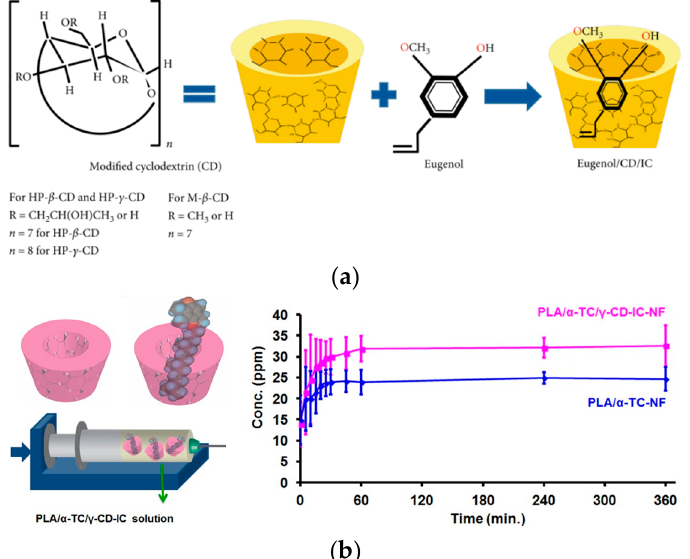
Figure 12. ( a ) Chemical structure of modified CD, eugenol, and schematic illustration of IC formation between CD and eugenol; Reprinted with permission from Ref. [178], Copyright 2020 Shahla Ataei et al. ( b ) schematic representations of γ -CD and α -TC/ γ -CD–IC, electrospinning of nanofibers from a PLA/ α -TC/ γ -CD–IC solution and cumulative release of α -TC from PLA/ α -TC–NF and PLA/ α -TC/ γ -CD–IC–NF into 95% ethanol. Reprinted with permission from Ref. [187], Copyright 2017 Wiley Periodicals, Inc.,